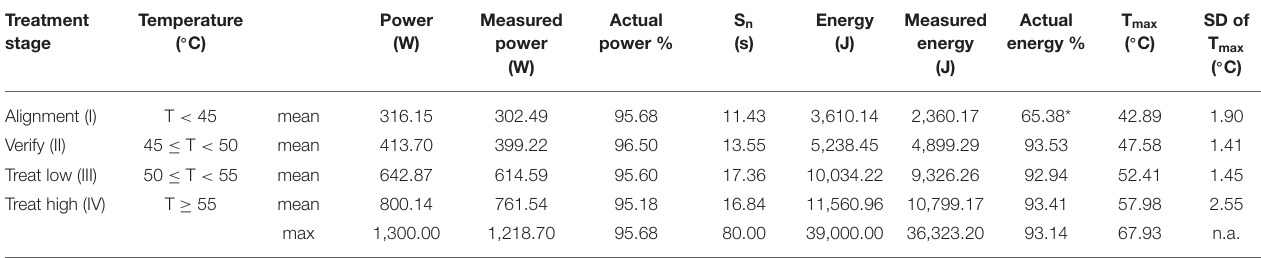
TABLE 2 | Summary of sonication parameters for each treatment stage for all considered patients. Treatment stage